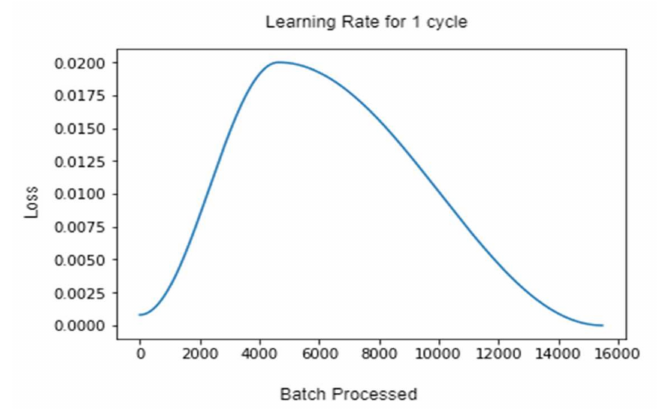
Figure 7. Graphs representing the learning rate for 1-Cycle